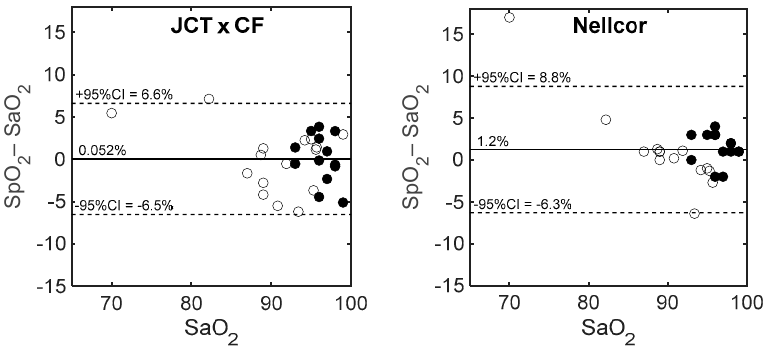
Figure 8. Bland–Altman plots of SpO 2 –SaO 2 vs. SaO 2 for Nellcor and JCT pulse oximeters are presented for the PICU children (full circles) and neonates (empty circles). The solid lines represent the mean of SpO 2 –SaO 2 and the dashed lines are the 95% confidence interval (CI).